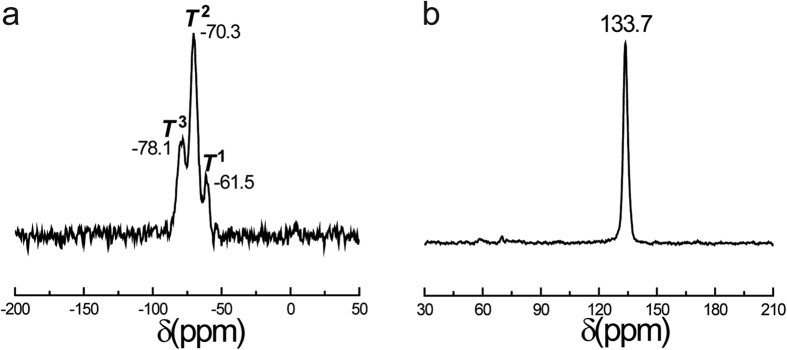
(a) 13Si MAS and (b) 13C CP MAS NMR spectra of PMOs synthesized with CTAB/SDS and P123 as bi-templates at 4.90 MPa of CO2 pressure.